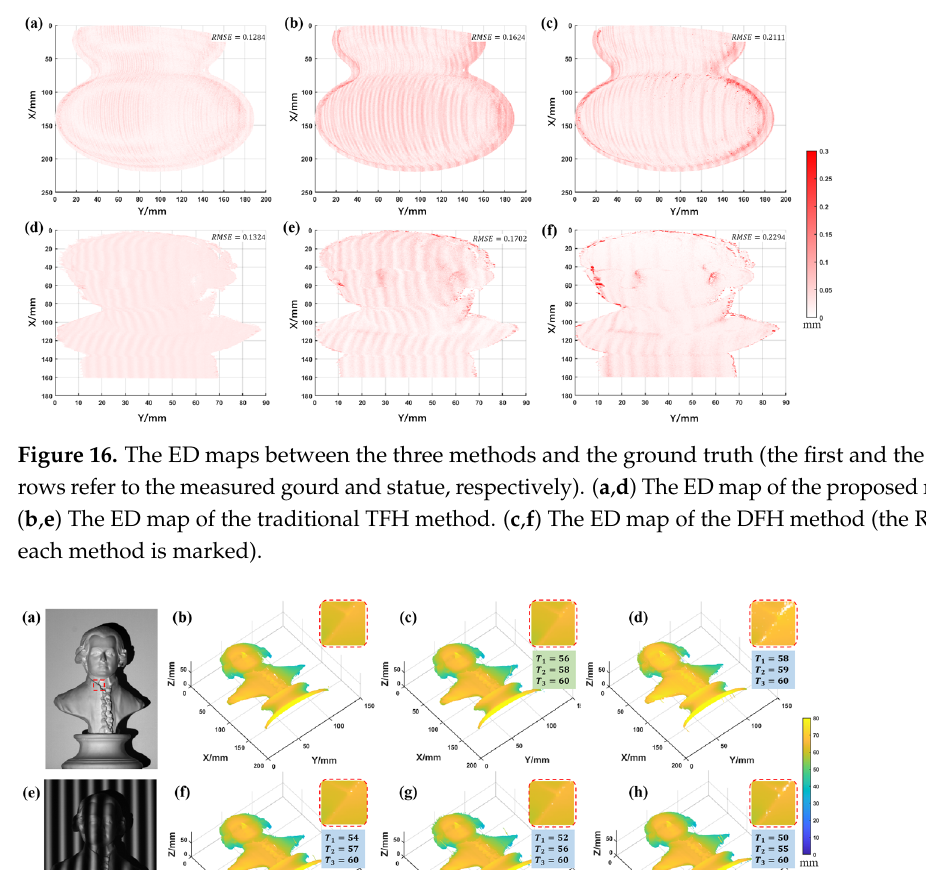
Figure 17. Measurement results under different period combinations. ( a , e ) The statue and deformed fringe pattern. ( b ) Ground truth. ( c ) Combination 1: 56, 58, 60 (combination 1 is optimal combination). ( d ) Combination 2: 58, 59, 60. ( f ) Combination 3: 54, 57, 60. ( g ) Combination 4: 52, 56, 60. ( h ) Combination 5: 50, 55, 60 (the small images in the upper right are enlarged images of the selected region).